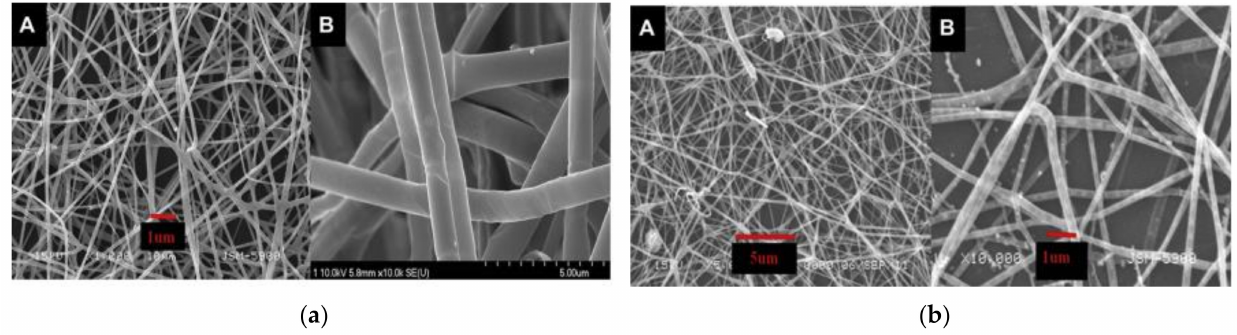
Figure 5. ( a ) (A) SEM; and (B) FE-SEM images of copper acetate (CuAc)/nickel acetate (NiAc)/PVA mat without heat treatment; ( b ) FE-SEM image of NiAC/CuAC/PVA mat NFs after sintering at 750 ◦ C for 3 h in argon atmosphere. Reprinted from reference [54] with permission from